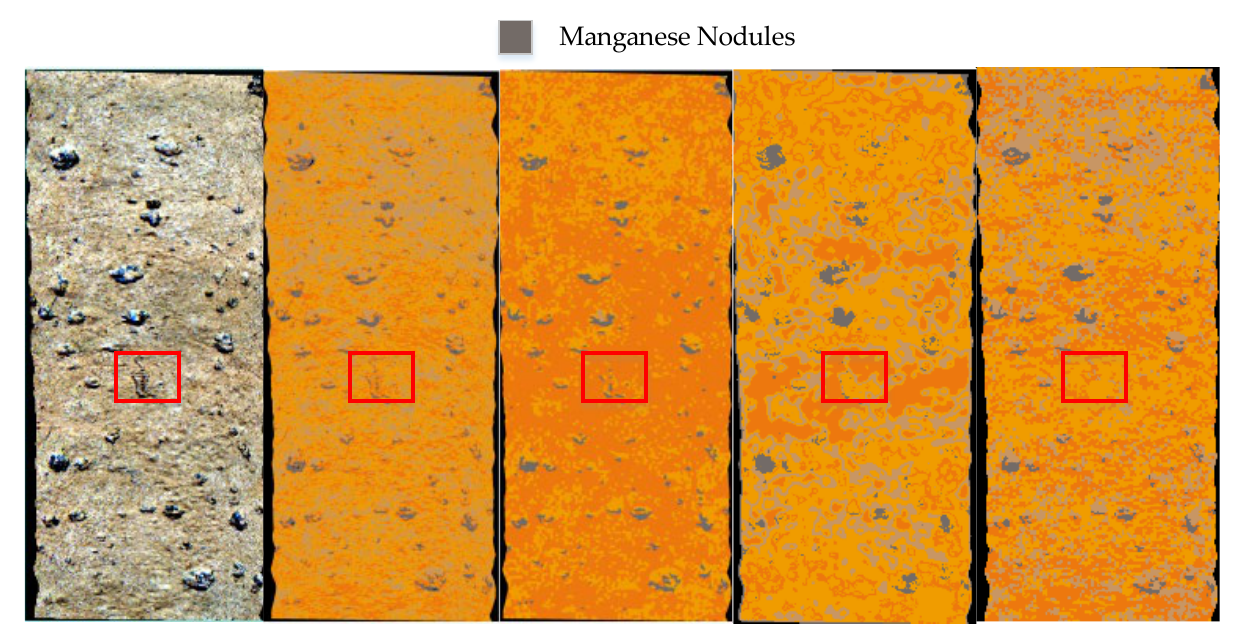
Figure 8. Comparison of manganese nodule classification results (from left to right, the original image, K-means, MSLIC-FCM, DKFCM, LMSLIC-FCM).